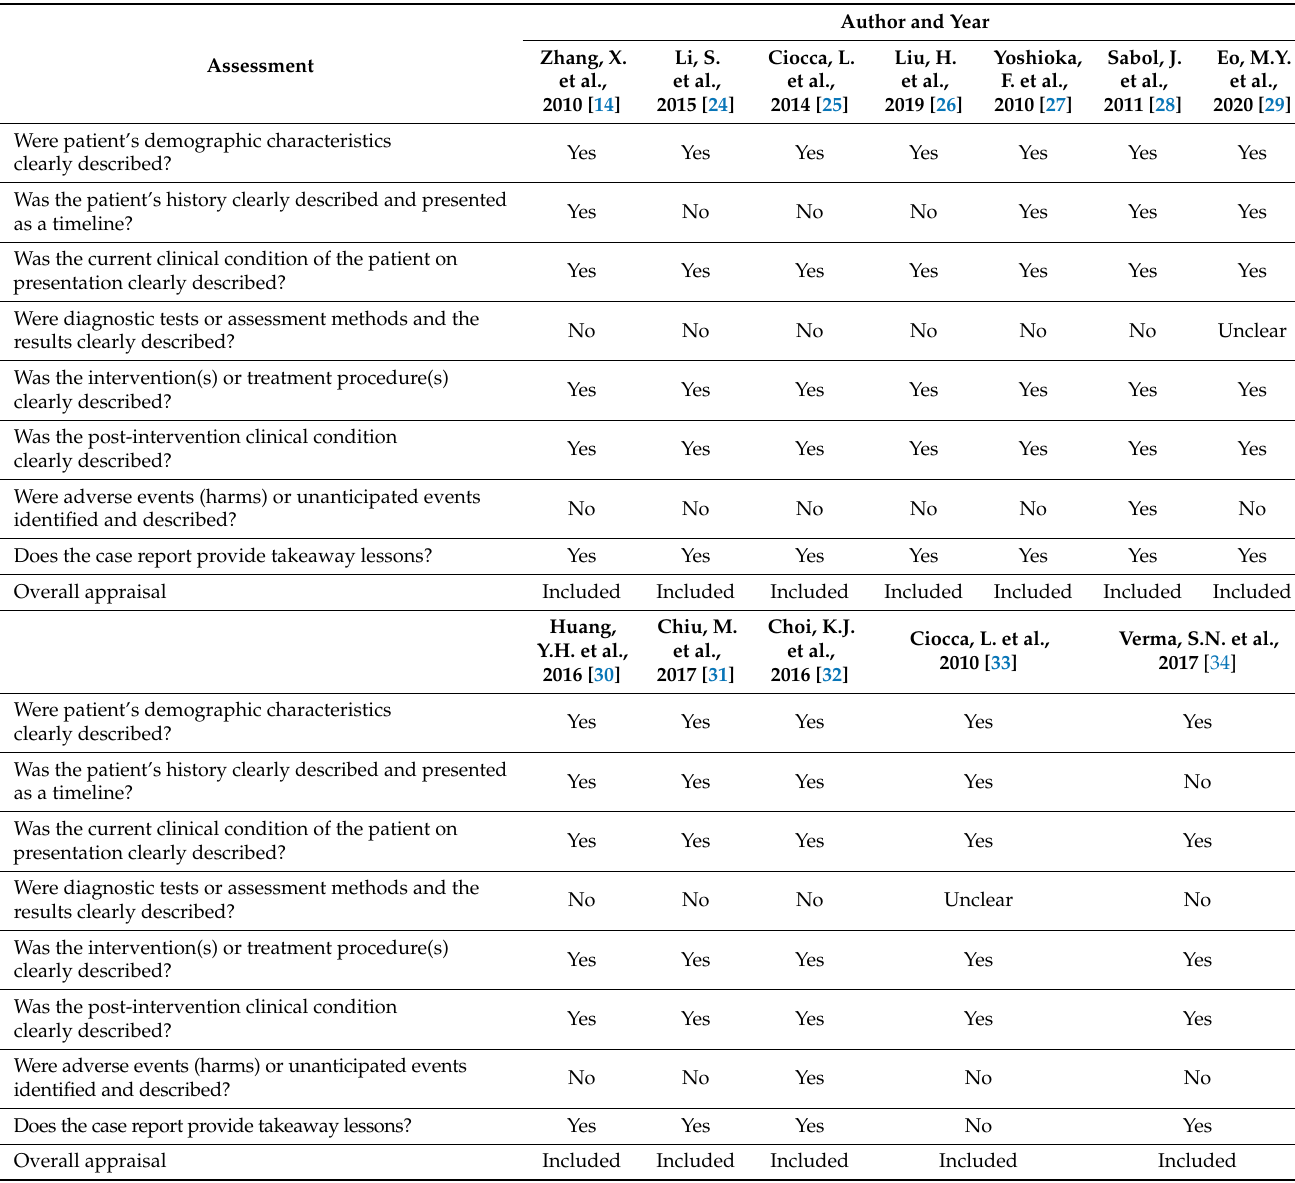
Table 2. Risk of bias for the case reports.